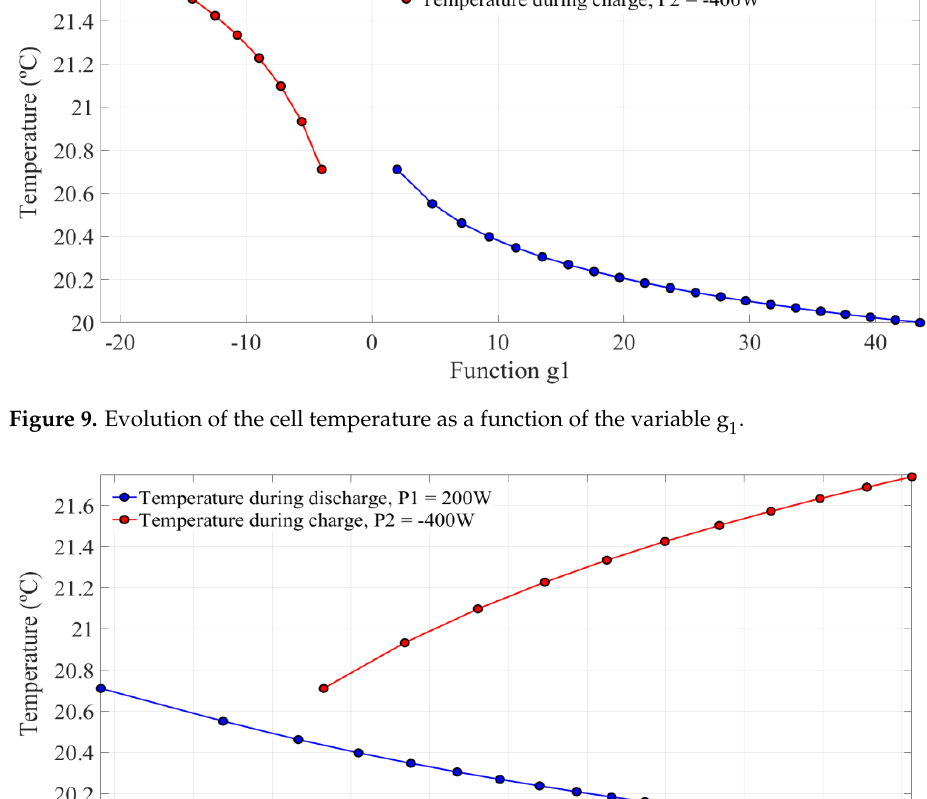
Figure 10. Evolution of the cell temperature as a function of the external voltage.